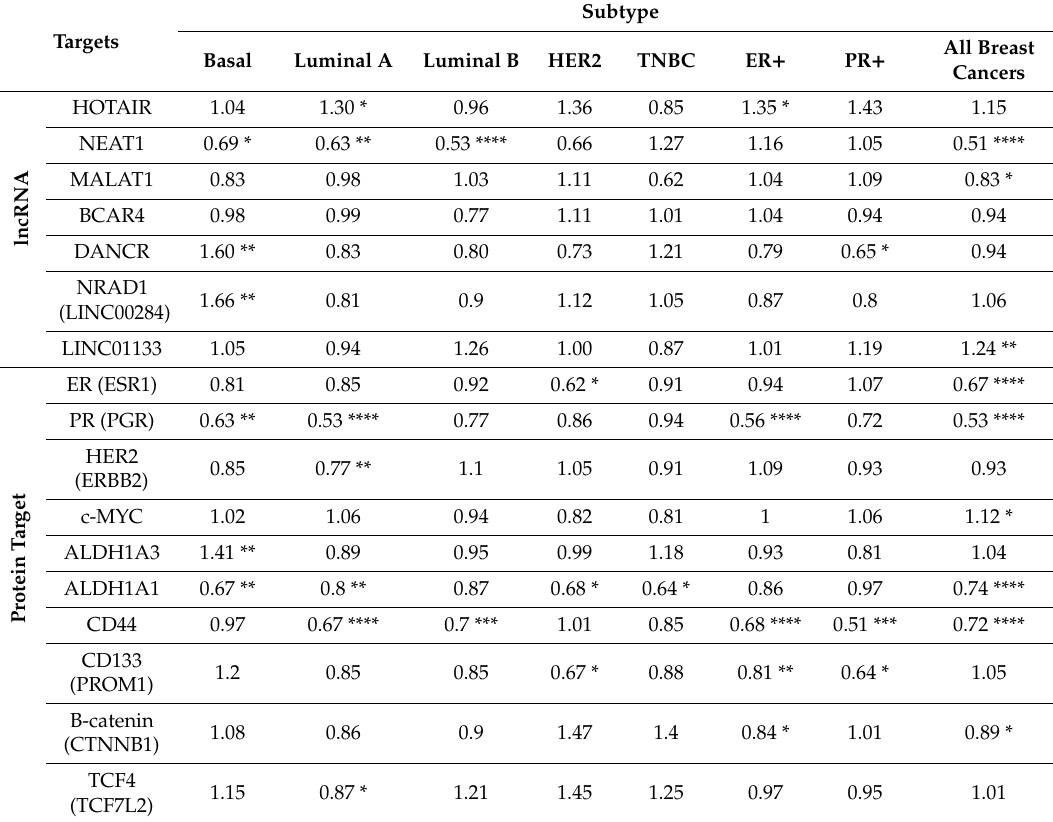
Table 4. LncRNA hazard ratio by breast cancer